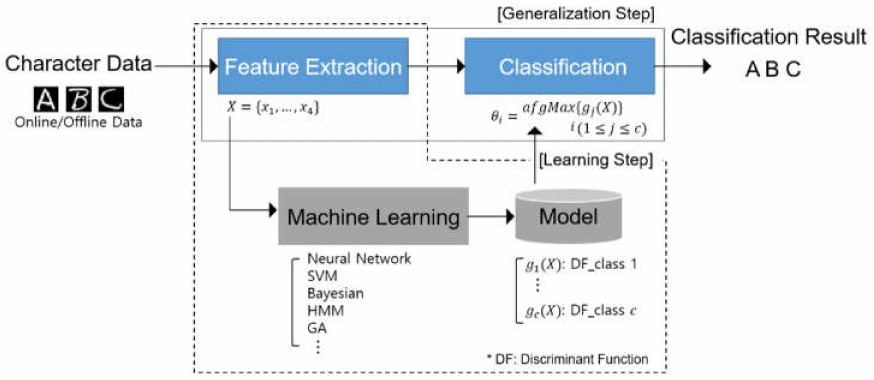
Figure 1. Process of character recognition system based on pattern